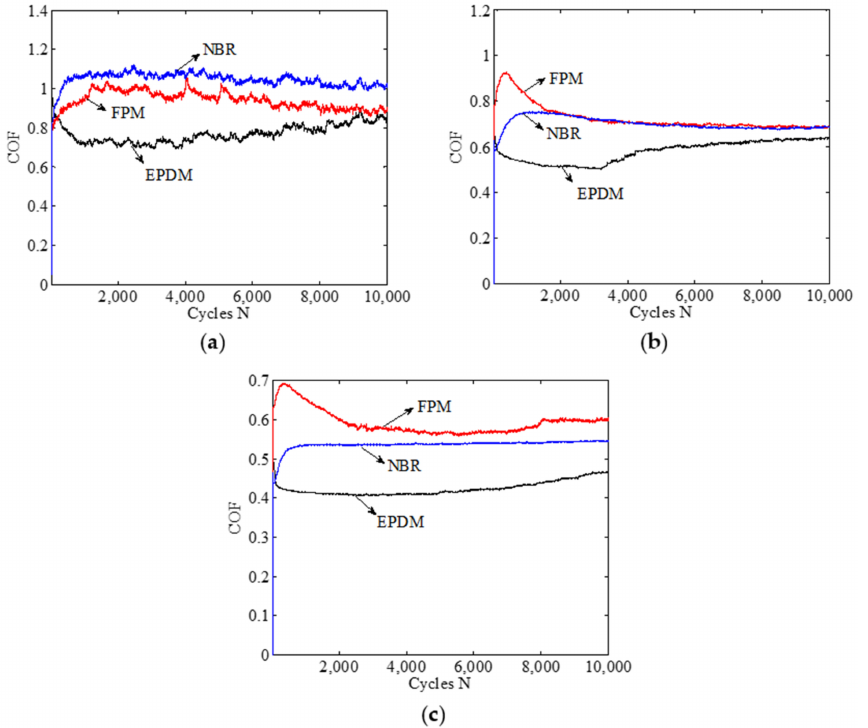
Figure 6. The friction coefficient curve of three rubbers under d = ± 0.45 mm, f = 10 Hz, and H = 70 Ha: ( a ) F n = 1 N; ( b ) F n = 5 N; and ( c ) F n = 10